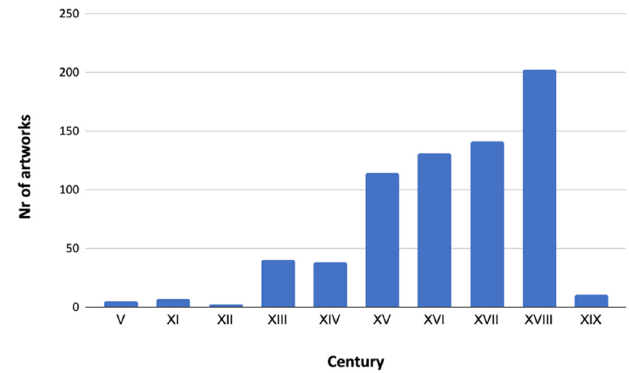
Figure 2. Distribution of the identifications within the different historic periods.